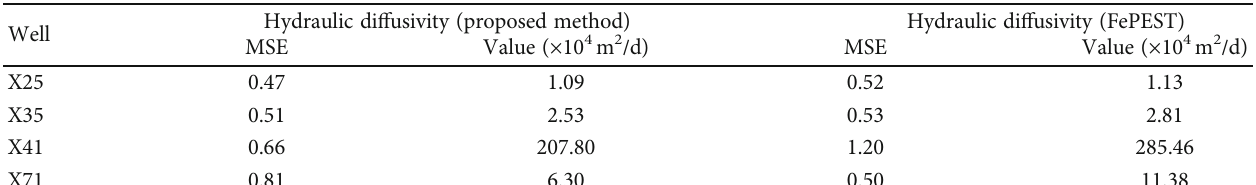
Table 3: Calculation results of hydraulic di ff usivity.